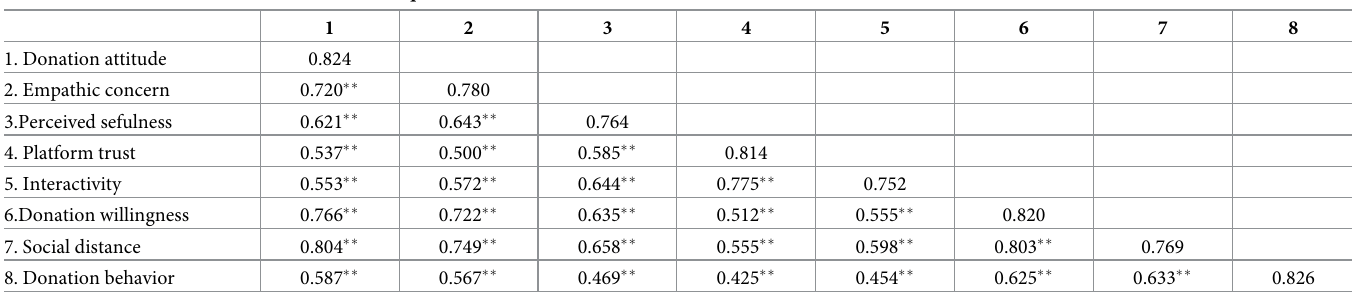
Table 5. Correlation coefficient matrix and the square root of the AVE.